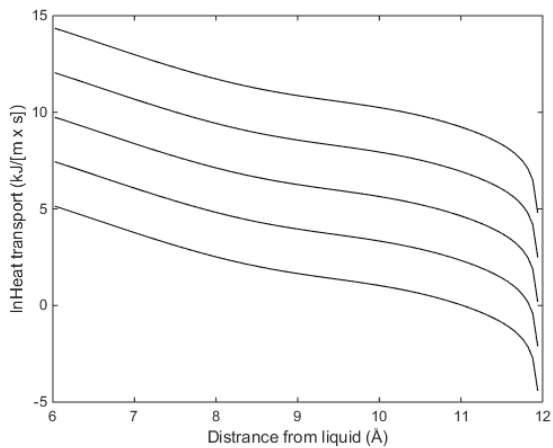
Figure 10. Calculated heat transport rates through hydrate/liquid water interface as a function of liquid-side diffusivity coefficient in Equation (10). Upper curve is for D liquid in Equation (10) equal to 1 × 10 −07 m 2 /s (top), 1 × 10 −08 m 2 /s, 1 × 10 −09 m 2 /s, 1 × 10 −10 m 2 /s, 1 × 10 −11 m 2 /s (bottom). Absolute minimum heat transport rate is 1.4 × 10 −10 kJ/(m×s), 1.4 × 10 −11 kJ/(m×s), 1.4 × 10 −12 kJ/(m×s), 1.4 × 10 −13 kJ/(m×s), and 1.4 × 10 −14 kJ/(m×s) for the same curves. Heat cannot be transported faster than it moves across the rate-limiting sections, with many dynamic changes related to the mass and heat transport drastically changing the mass and heat transport rates. As an example, the calculated heat transport rates corre- sponding to the distance of 6 Å from the liquid side would be four orders of magnitude higher than the values used Figure 10. On the other hand, the heat conduction coefficient of 0.57 W/(m·K) (see Table 2), i.e., 5.7 × 10 −4 kJ/(m·s·K), will still translate into heat transfer orders of magnitude faster than the mass transport-controlled rates on the left-hand side of Equation (9). The heat transport models along the lines presented here can be incorporated into simple kinetic models such as the classical nucleation theory (CNT) for use in hydrate phase transition modeling at the pore level in reservoir simulation. Yet, other applications are kinetic extensions of our hydrate risk evaluation models (see, for instance, [24,25]). In this work, we have shown that mass transport through hydrate/liquid water inter- face is very slow. This issue is likely to limit hydrate film growth, and this may interfere the balance between distribution of released heat and temperature increase in surround- ings. This may lead to partial re-dissociation of the hydrate film. As an illustration of the slow transport through hydrate films, we will utilize a simple version of CNT for spherical hydrate cores. CNT can be formulated as 𝐽 = 𝐽 0 𝑒 −𝛽𝛥𝐺 𝑇𝑜𝑡𝑎𝑙